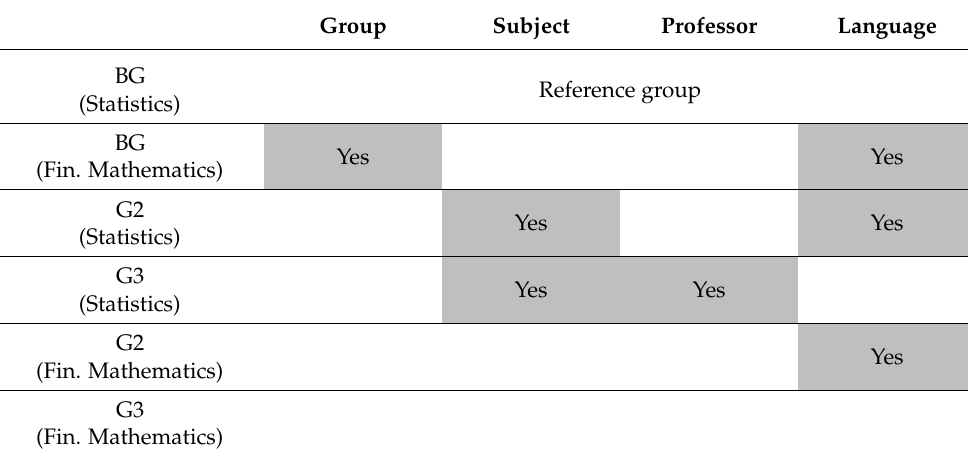
Table 1. Groups by subject and similarity to the